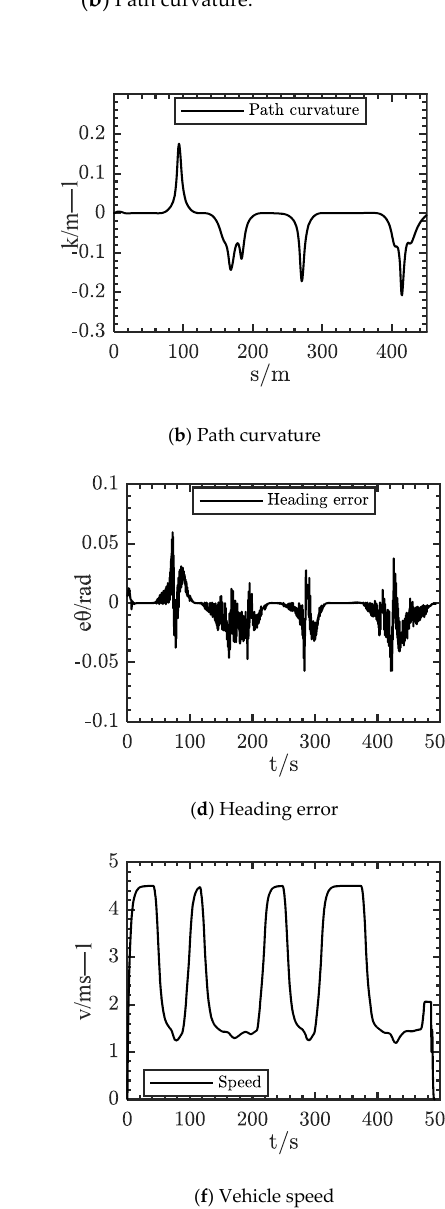
Figure 10. Vehicle control input. The lateral displacement error and heading angle error are shown in Figure 10c,d. From the graph, it can be seen that the optimized motion controller could effectively guar- antee the convergence of the heading angle deviation and the lateral displacement devia- tion. The average lateral deviation during the whole process was less than 15 cm. The maximum lateral deviation was 12 cm at the U-turn, which was due to the larger curva- ture. The maximum heading angle deviation did not exceed 5 degrees. It could meet the requirements of the motion planner. The wheel angle and the vehicle speed are shown in Figure 10e,f. The maximum front wheel rotation angle reached 18 degree at the U-turn. It could meet the maximum steering angle limit. The speed of the reference point was 4.5 m/s. However, due to the limitation of lateral acceleration, the speed was limited to 1.5 m/s during the turn. The prosed method can slow down in advance before turning. At the same time, it can satisfy the constraints of the control input. As a result, the tracking effect of the proposed motion controller was proven. The predicted step size was 30 and the average computation time was less than 30 ms during the whole process. This can meet the real-time requirement and guarantee the stability of the vehicle. 5. Conclusions An optimized trajectory planner and motion controller framework were proposed in order to ensure the safety of autonomous driving in unstructured environments. On the one hand, the nonlinear optimization method was applied to smooth the reference road based on the vehicle kinematic model in the space domain. The trajectory planning con- sisted of longitudinal and lateral planning sub-tasks. The multilayered search method in